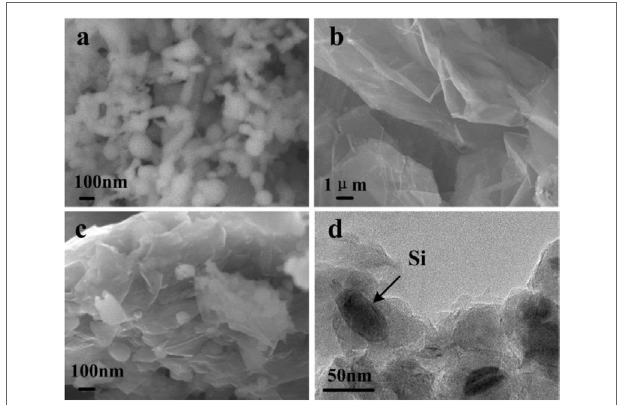
FigUre 1 | FESEM images of Si nanoparticles (a) , expanded graphite (B) , Si@SiO x /GNS nanocomposite (SG1) (c) , and TEM image of SG1 (D) .